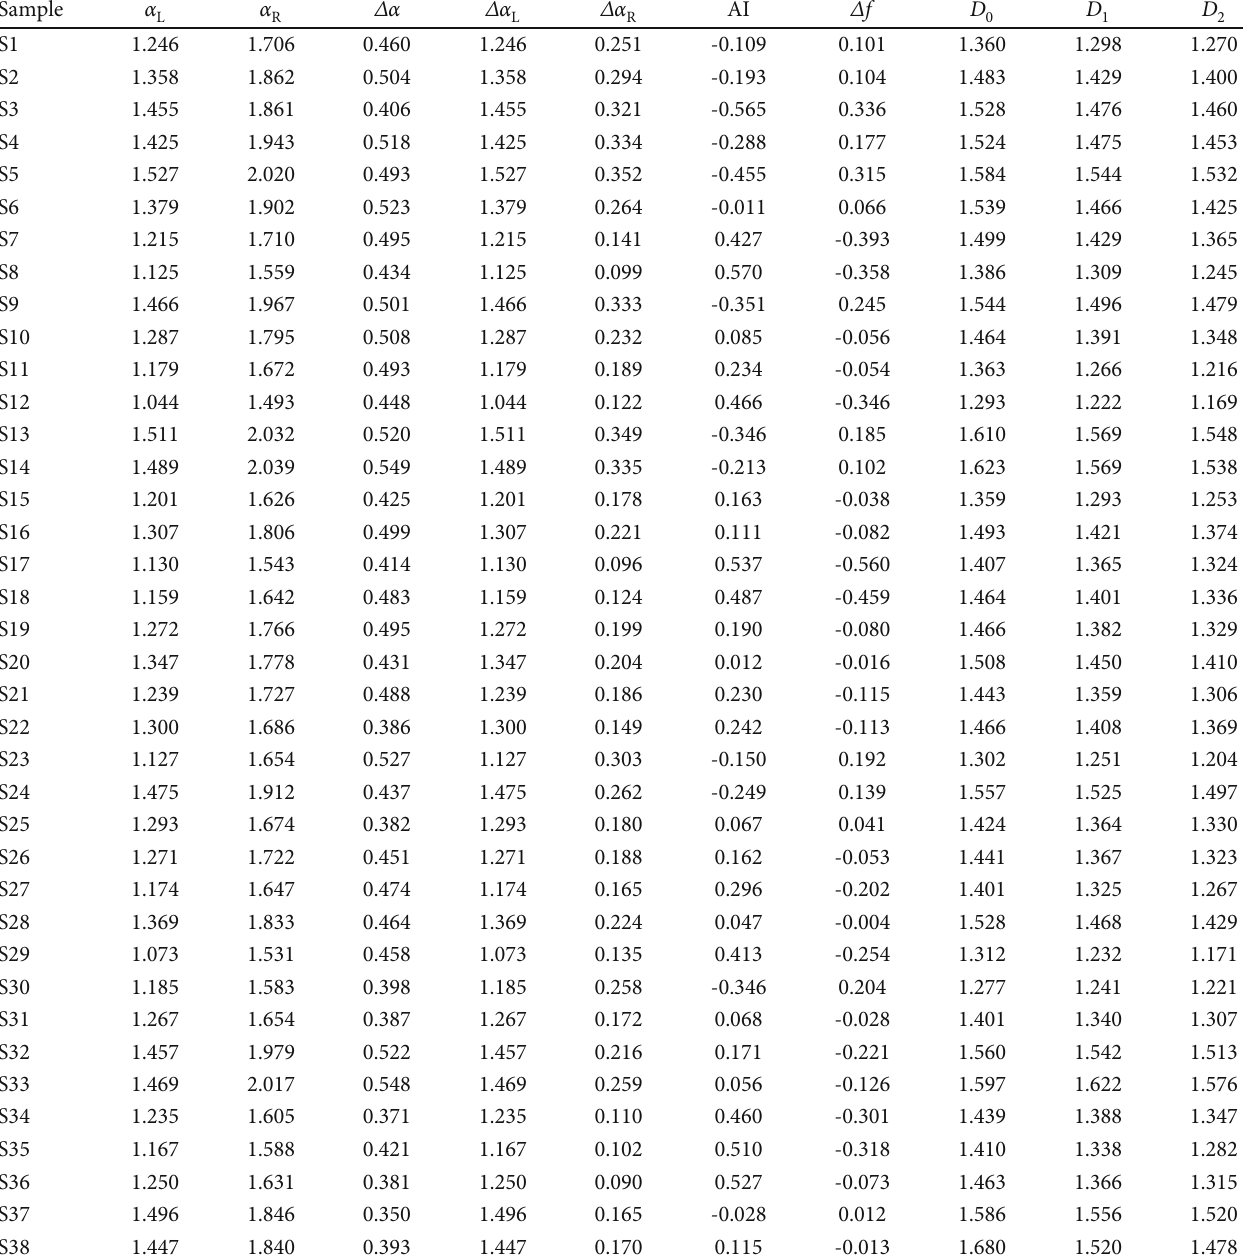
Table 2: Petrophysical properties and parameters of multifractal analysis on dolostone